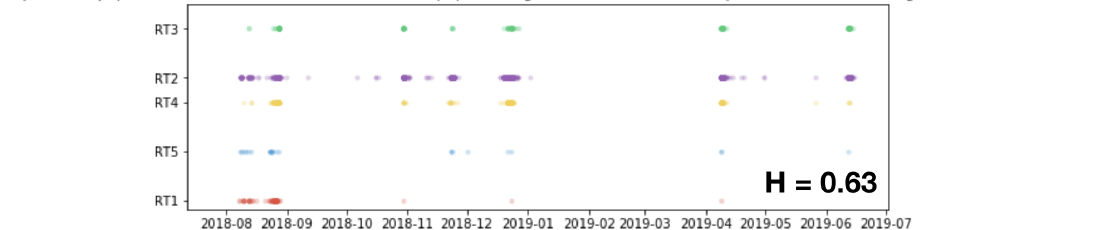
Figure 10. Shares over time, grouped by community, of a randomly chosen URL. The entropy for this specific sharing pattern is H =